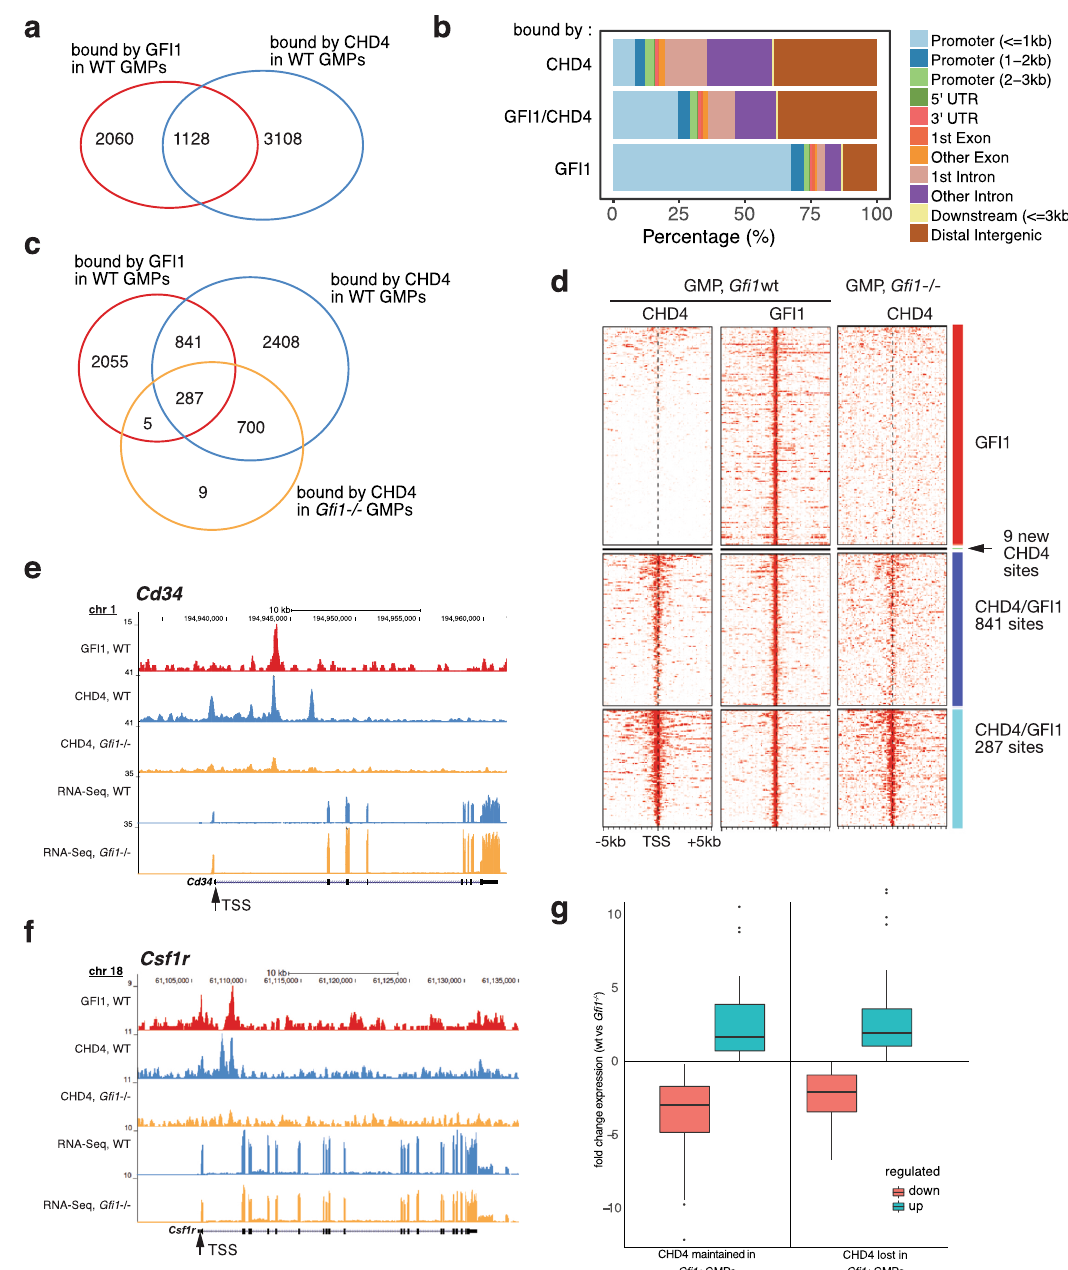
Fig. 3 GFI1 and NuRD complex member CHD4 co-occupy sites at chromatin from granulocyte myeloid progenitors (GMPs). a Venn diagram indicating the number of sites occupied by GFI1, CHD4, or both in GMPs according to ChIP-seq experiments done with GMPs. b Relative distribution of sites occupied by GFI1, CHD4, or both in percent of all sites in promoter regions, 3 ′ and 5 ′ untranslated regions (UTRs), introns, exons, or other distal regions. c Venn diagram indicating the number of sites occupied by GFI1 in WT GMPs, CHD4 in WT GMPs and CHD4 in GFI1 de fi cient GMPs. d Heatmap of ChIP-seq results for sites occupied by GFI1, or GFI1 and CHD4 in WT GMPs or in GMPs sorted from GFI1 de fi cient mice ( G fi 1 KO). Genes are sorted according to GFI1 occupation. Red: genes occupied by GFI1, but not by CHD4, dark blue: N = 841: sites occupied by both CHD4 and GFI1 in wt GMPs which lose CHD4 occupation when G fi 1 is deleted (i.e., in G fi 1 KO GMPs), pale blue: N = 287: sites occupied by both CHD4 and GFI1 in wt GMPs which maintain CHD4 occupation when G fi 1 is deleted (i.e., in G fi 1 KO GMPs). e Schematic depiction of the locus encoding murine CD34 and f the Csf1r locus encoding M-CSFR. Shown is the enrichment of reads after ChIP-seq with antibodies against GFI1 or CHD4 in GMPs from either WT or G fi 1 KO mice and the enrichment of reads after an RNA-seq experiment from WT of G fi 1 KO GMPs. The transcription start site is indicated (TSS, transcription start site). Annotations represent locations on the mouse genome version GRCm38 (mm10). g The promoters of the genes targeted by GFI1 and by CHD4 were separated into two groups according to the presence of CHD4 in G fi 1 KO cells (w_CHD4 and wo_CHD4). The groups were then separated into two subgroups according to the direction of the fold change in expression after G fi 1 deletion (up or down). For the comparison w_CHD4_up vs. wo_CHD4_up, the p -value is 0.80. For the comparison w_CHD4_down vs. wo_CHD4_down, the p -value is 0.0095. The lower and upper hinges correspond to the fi rst and third quartiles (the 25th and 75th percentiles). The whiskers extend up to 1.5 times the inter-quartile range and data beyond this point were plotted individually.